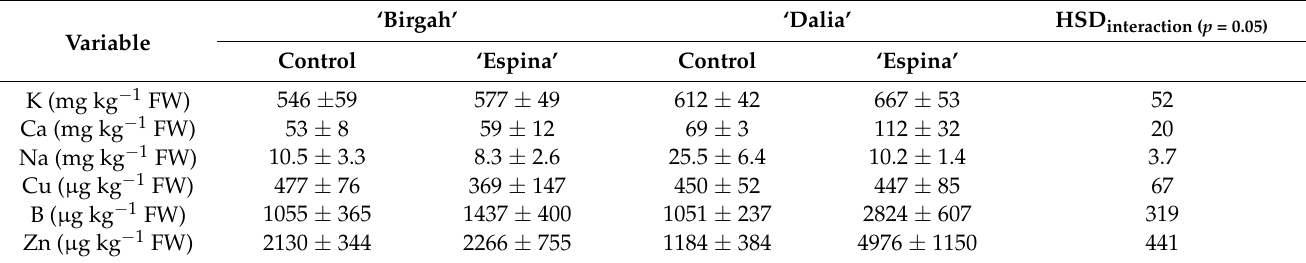
Table 6. Potassium, calcium, sodium, copper, boronandzincconcentrationsineggplants(mean ± standard deviation) as affected by ‘cultivar × grafting’